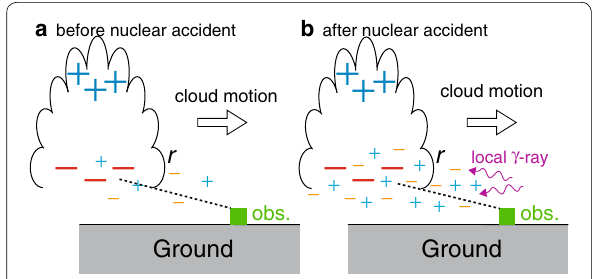
Fig. 1 Illustration of electrostatic shielding of cloud charge (large “ + ” and “ ”) by surrounding ions (small “ + ” and “ − b when floating radionuclides emit extra gamma rays that